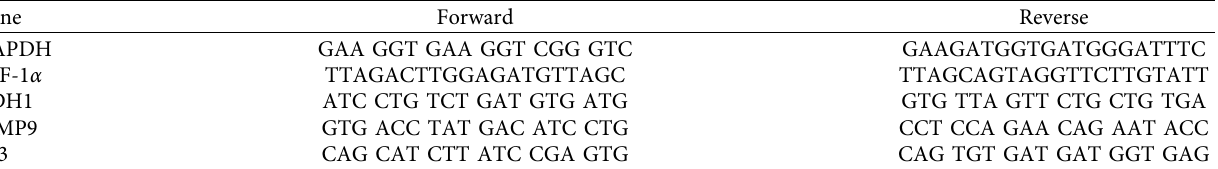
Table 1: Real-time PCR primers.